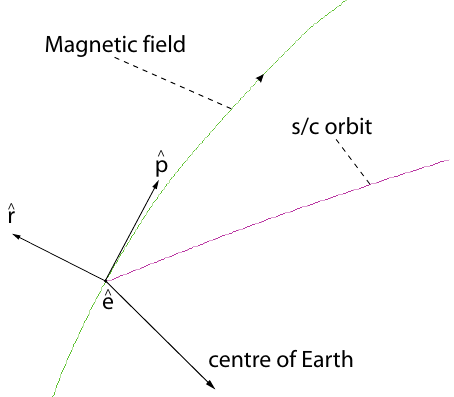
Fig. 1. Schematic illustration of the field-aligned coordinate system used in this study. The green line represents a magnetic field line and the purple line represents the spacecraft orbit. See text for the definition of the coordinate axis.